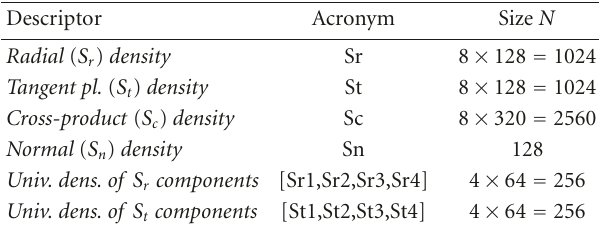
Table 4: Density-based 3D shape descriptors and their sizes.